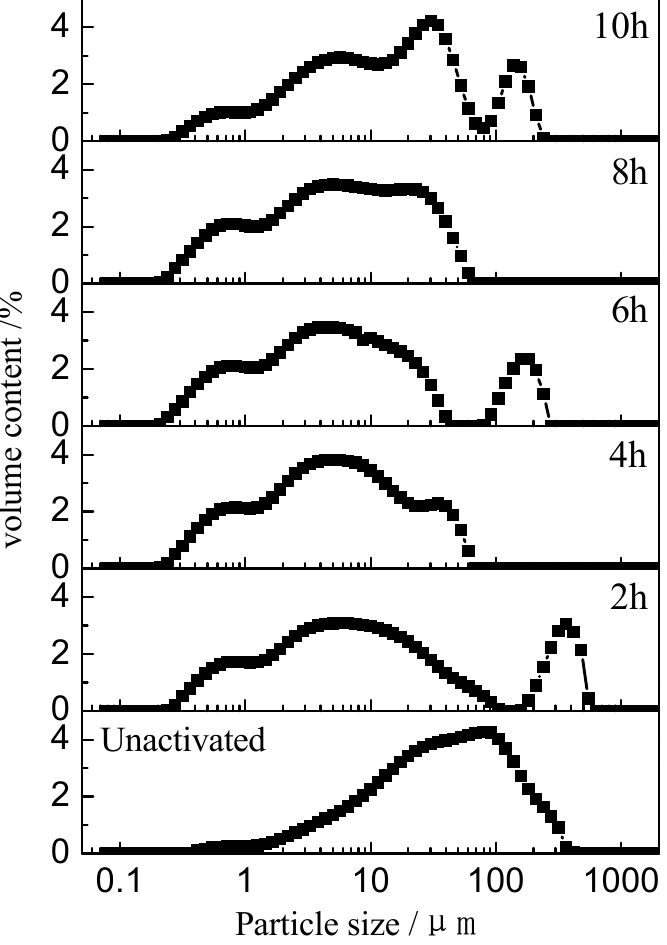
Figure 3. Particle size distributions of the activated and unactivated samples at different milling times.